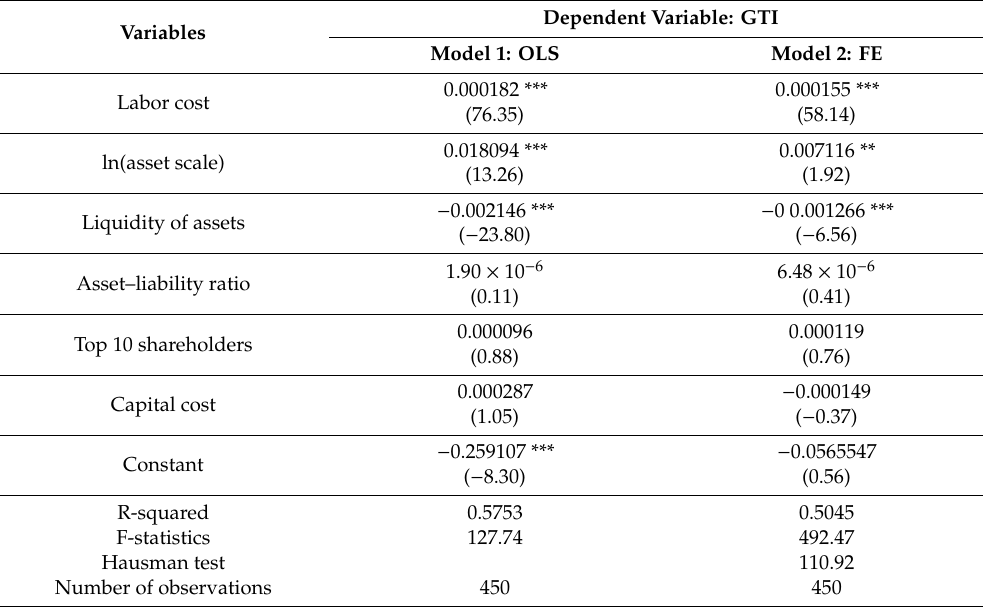
Table 6. Parameter estimation of labor cost impact on green technological innovation.